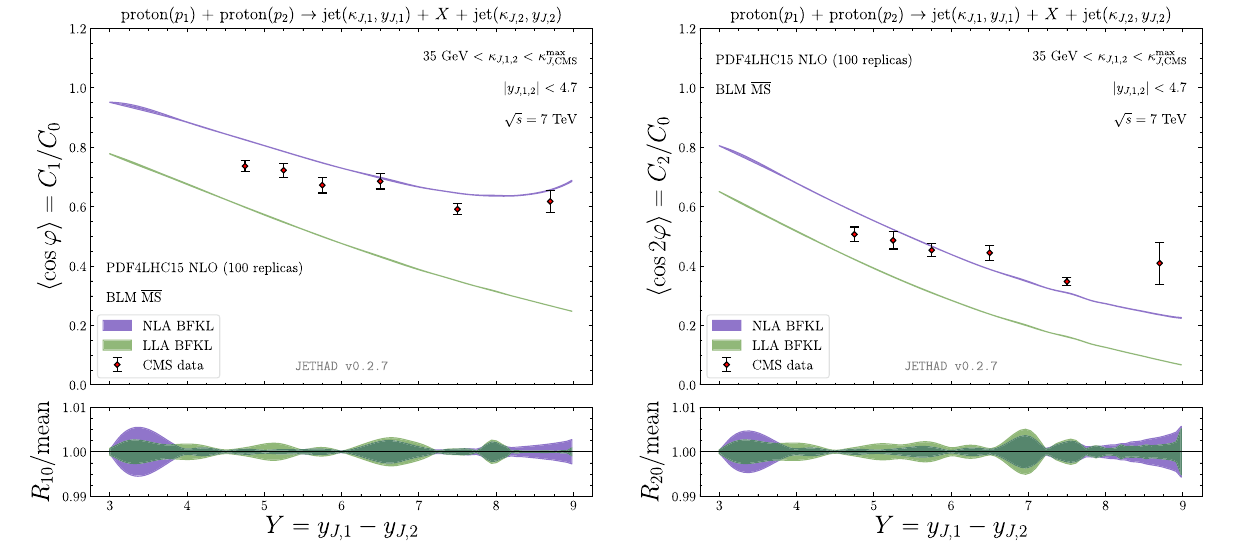
Fig. 3 Y -dependence of R 10 ≡ C 1 / C 0 and R 20 ≡ C 2 / C 0 of the Mueller–Navelet jet production (left panel of Fig. 2) for μ F 1 , 2 = μ R = √ μ BLM s = 7 TeV ( symmetric CMS configuration). Calculations and R